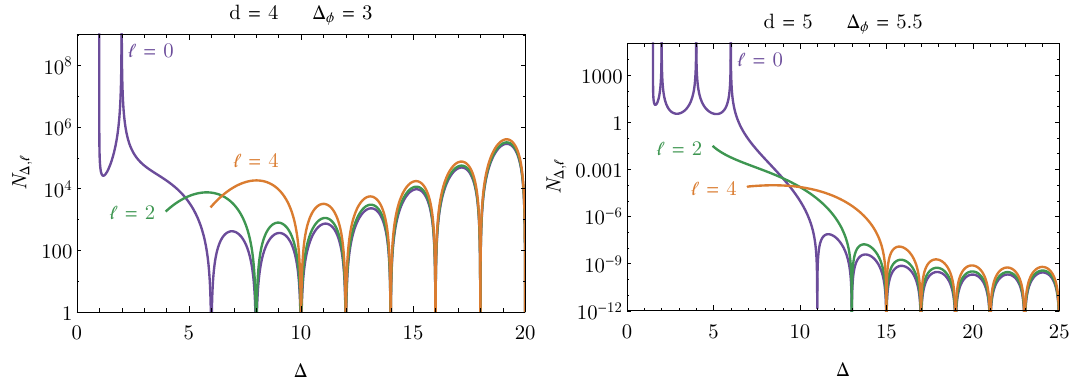
Figure 2 . The coefficient ∆ ,ℓ of eq. (1.14) as a function of ∆ and for ℓ = 0 , 2 and 4 in two N different cases: the left panel corresponds to d = 4 spacetime dimensions with a scalar operator of scaling dimension ∆ φ = 3; the right panel to d = 5 and ∆ φ = 5 .